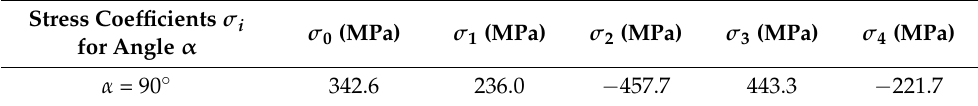
Table 2. Stress coefficients of fourth-order polynomial stress